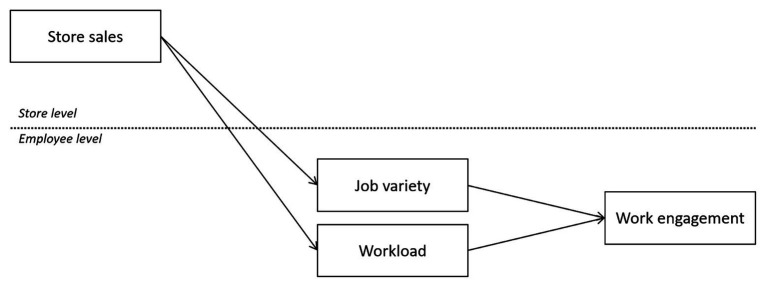
Conceptual model.